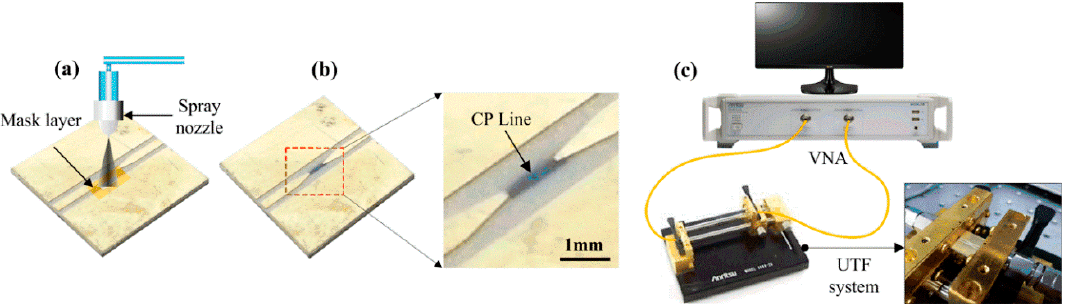
Figure 3. Sample preparation and experimental system for sample measurement; ( a ) Spray method for PEDOT:PSS line; ( b ) Pattern of the PEDOT:PSS line between the signal (S) electrodes; ( c ) Experimental system for sample measurement.